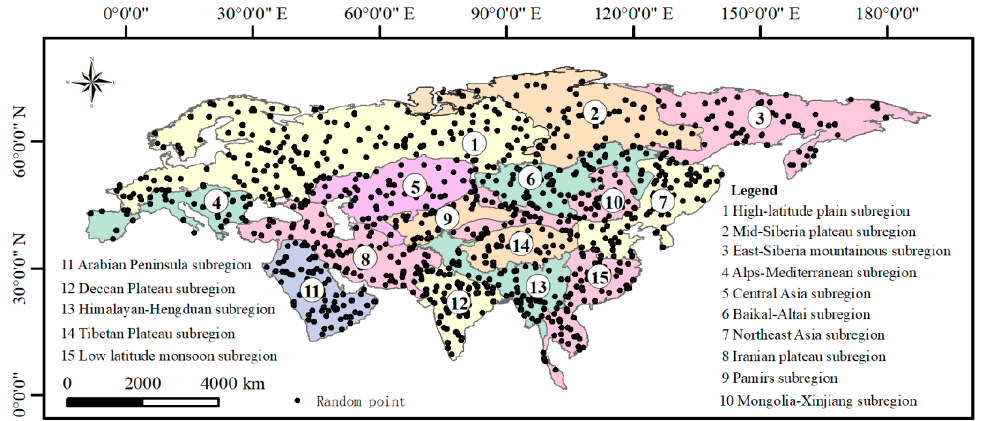
Figure 10. Distribution of random points in the Eurasian continent.